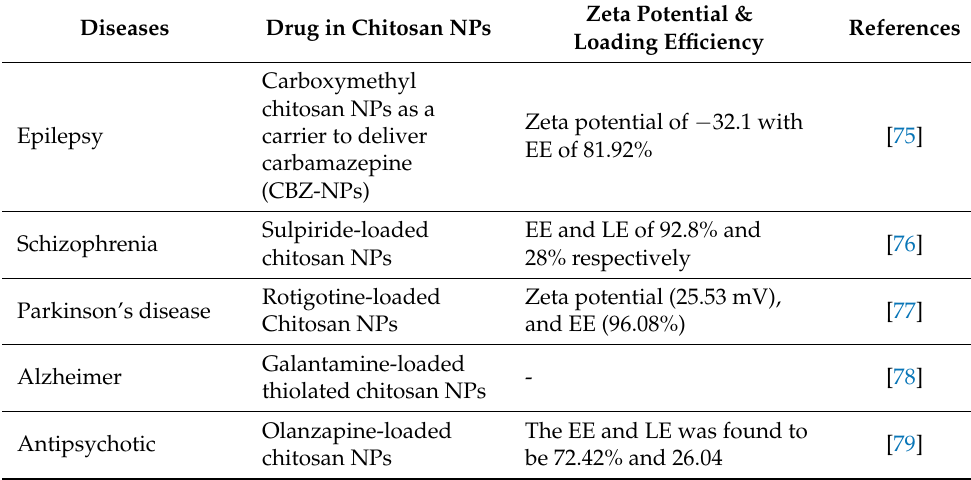
Table 3. Chitosan NPs in neurological